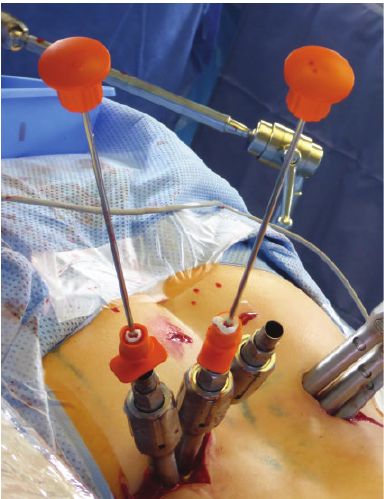
Figure 4: Intraoperative setting. The injection cannulas had been filled with bone cement and had been introduced through the screw extenders into the screw heads. The pushers were inserted to inject the bone cement through the cannulated screws and their fenestrations in the distal third of the thread into the vertebral body under fluoroscopic